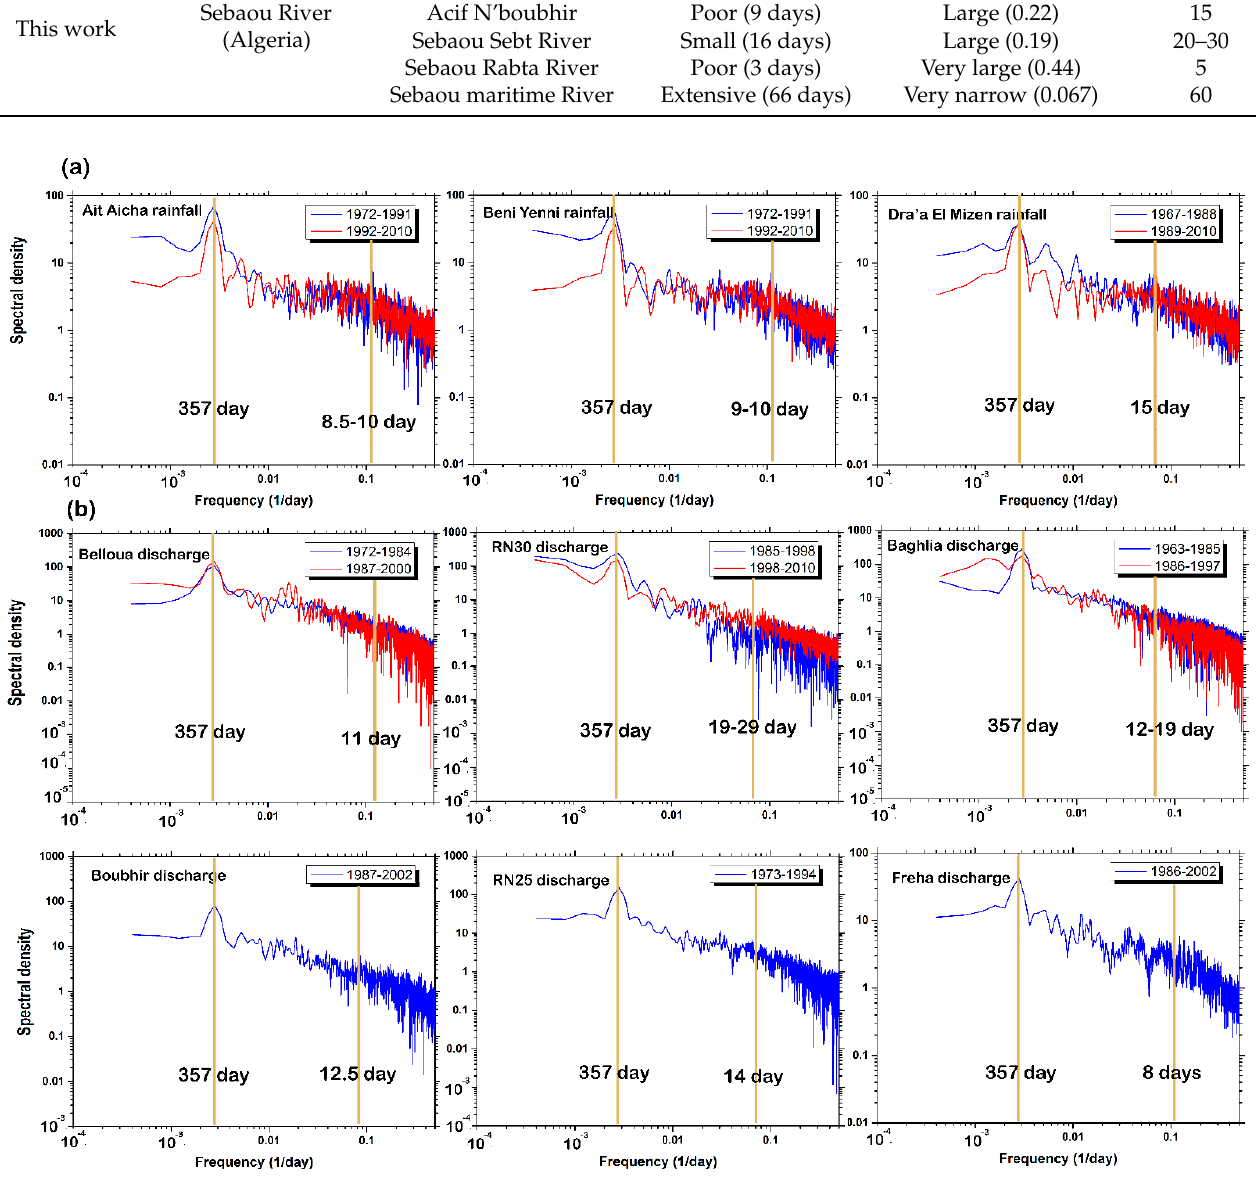
Figure 6. Noise analysis of ( a ) rainfall time series (Ait Aicha, Beni Yenni and Dra’a El Mizen) and ( b ) different runoff time series of Sebaou River basin based on log-log representation spectra.